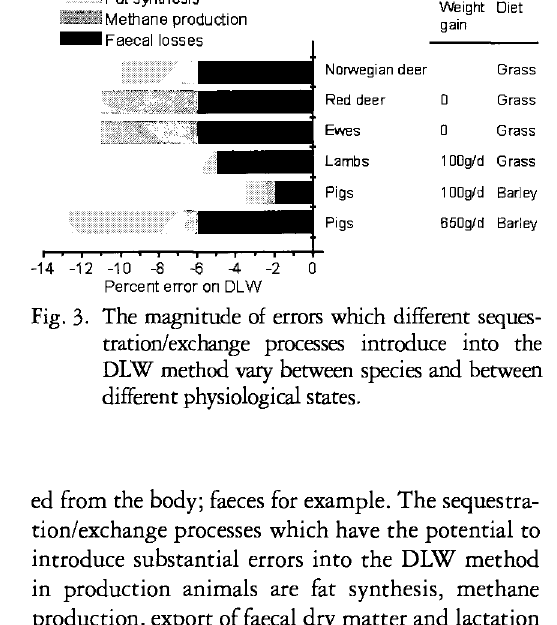
Fig. 3. The magnitude of errors which different seques tration/exchange processes introduce into the DLW method vary between species and between different physiological